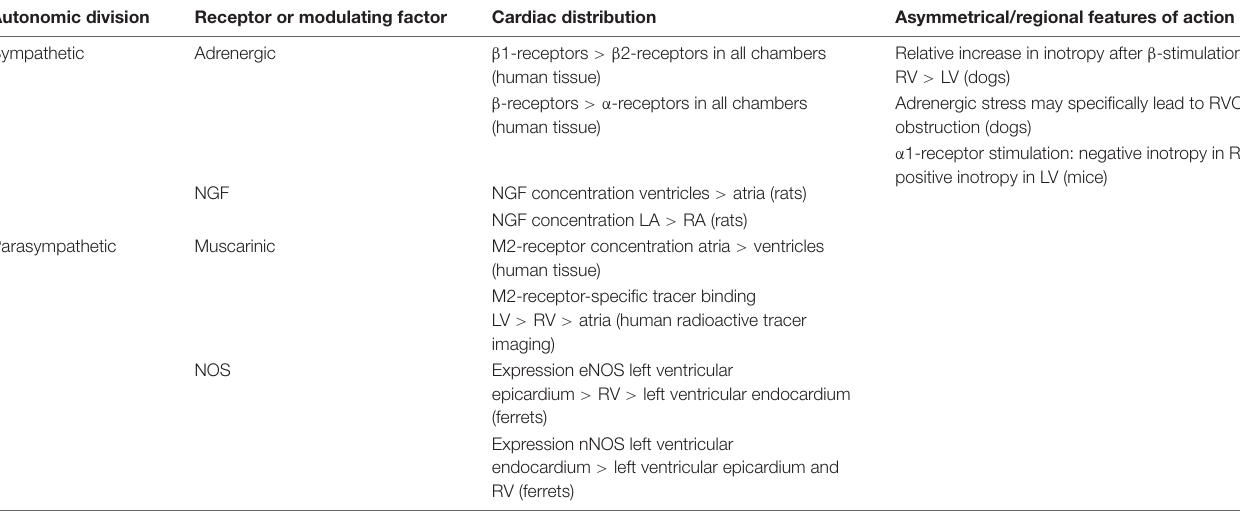
TABLE 4 | Asymmetry and regional differences in the distribution and response of cardiac autonomic receptors and modulating factors. Autonomic